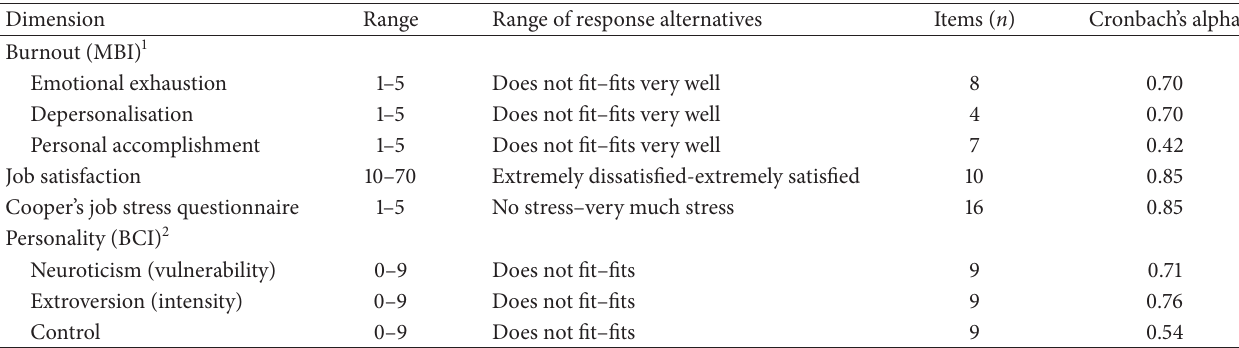
Table 1: Description of the